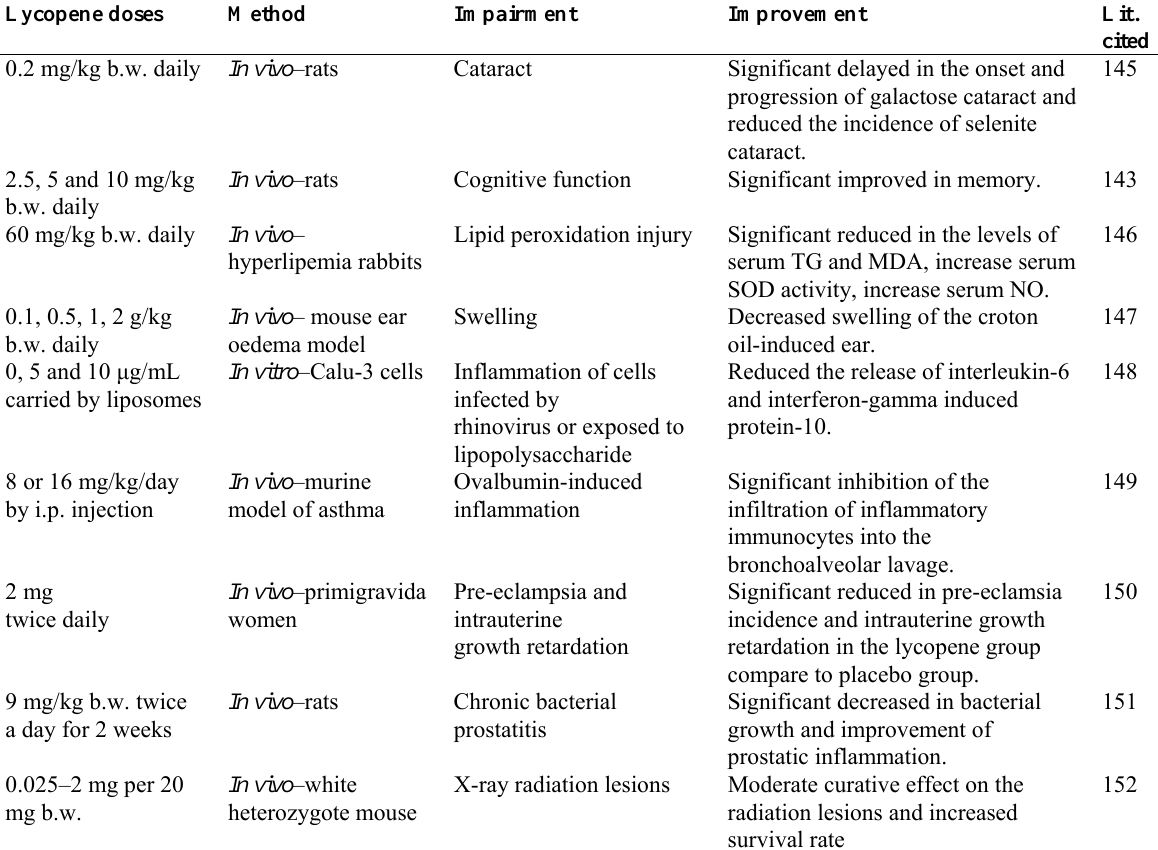
Table 3. Action of lycopene in improving the impairment of other